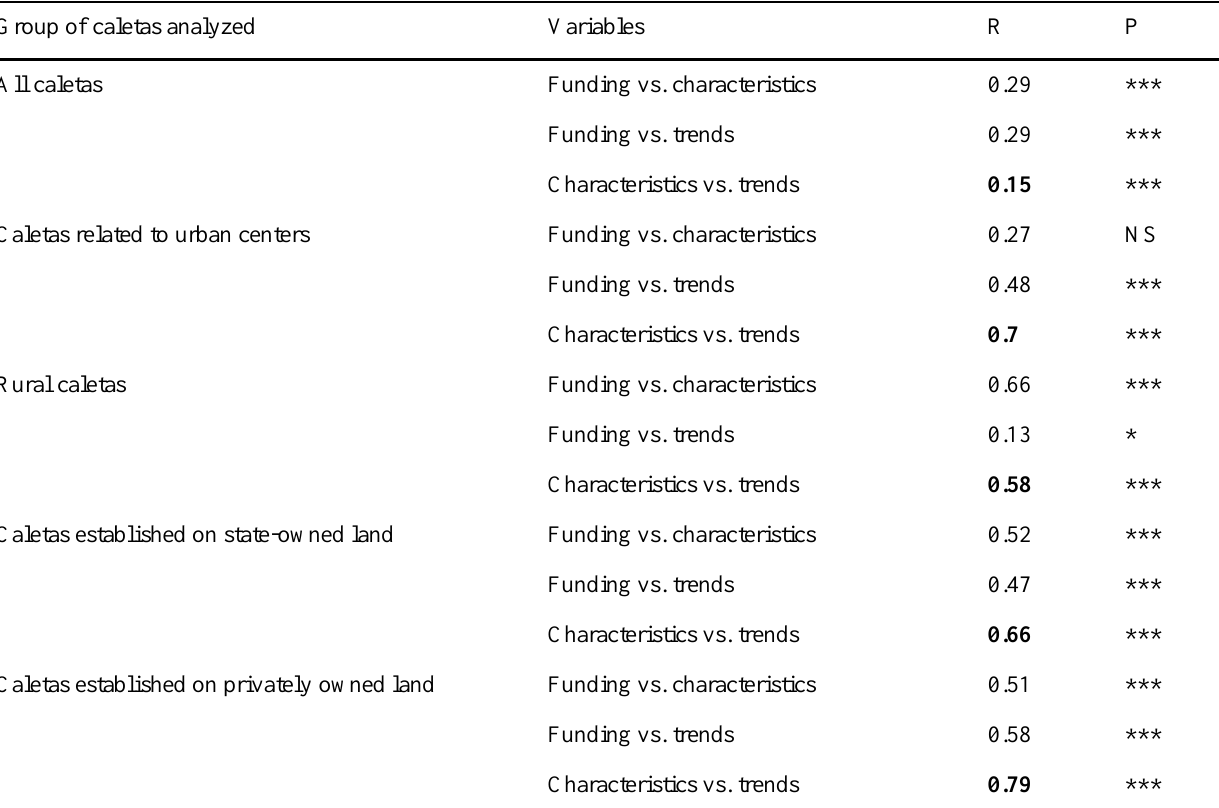
Caletas established on privately owned land Funding vs.